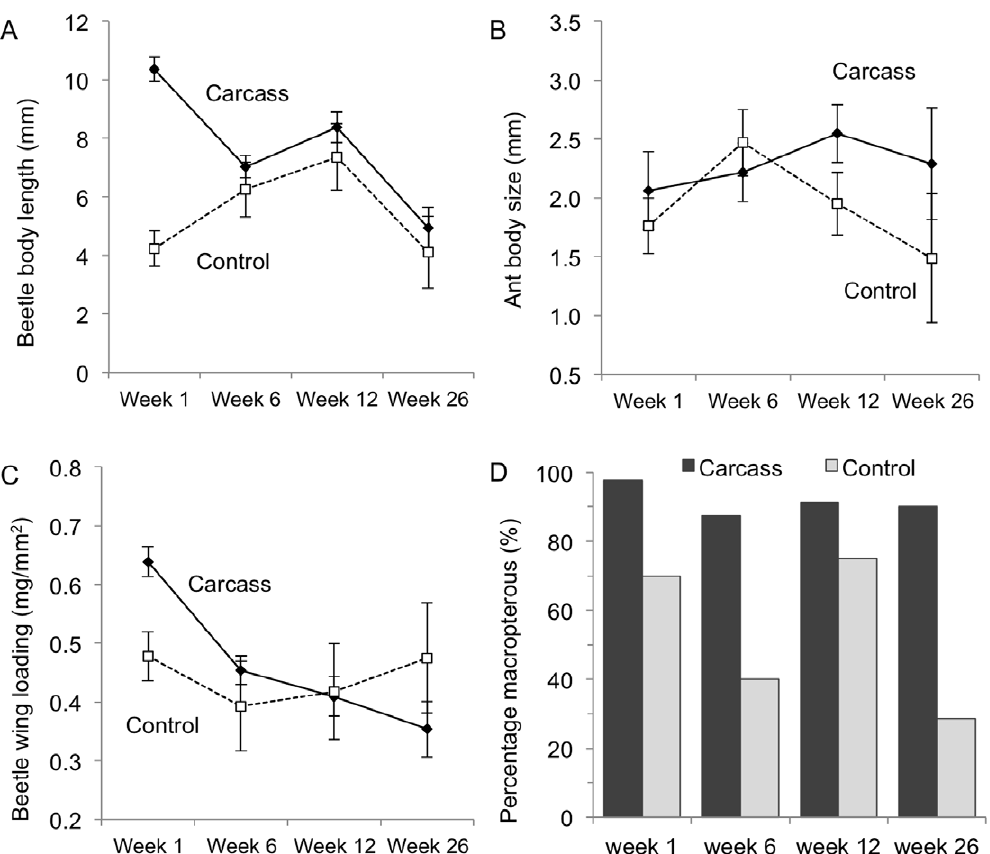
Figure 6. Differences in insect morphological traits between carcass and control sites. (a) Beetle species at carrion during week 1 were larger on average than those at control sites. (b) Beetle species at carrion during week 1 had higher wing loadings on average than beetle species at control sites. (c) No differences in ant body size were observed at different stages of carrion decomposition. (d) Macropterous beetles were always more prevalent at carcass sites that control sites. Error bars show mean 6 SE.